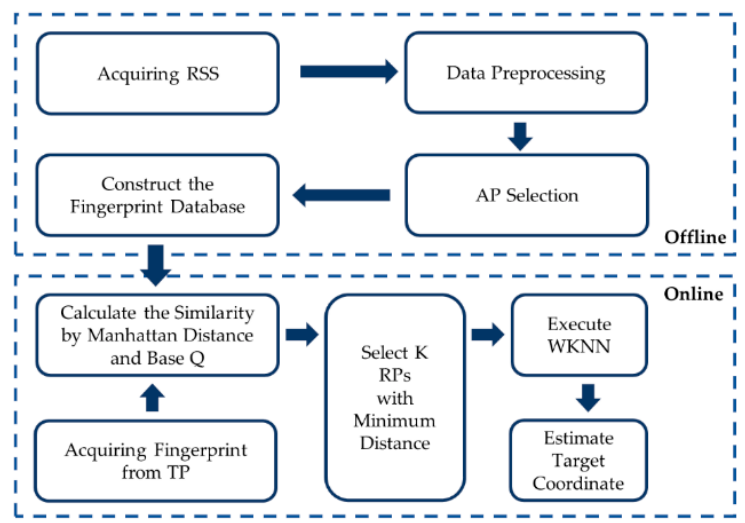
Figure 3. Flowchart of proposed algorithm.